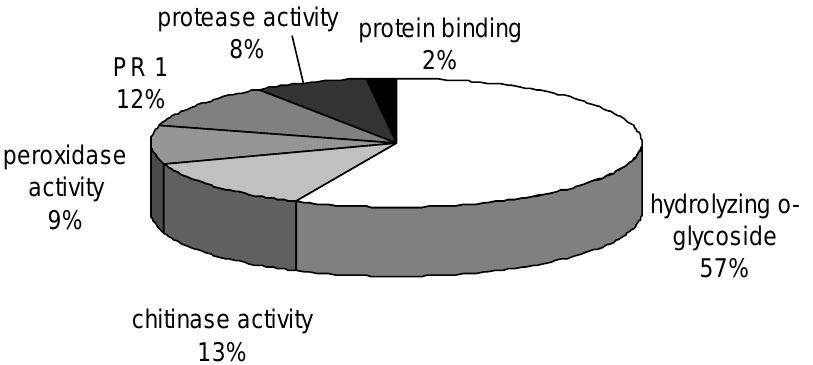
Figure 5. Proteins clustered to their functional